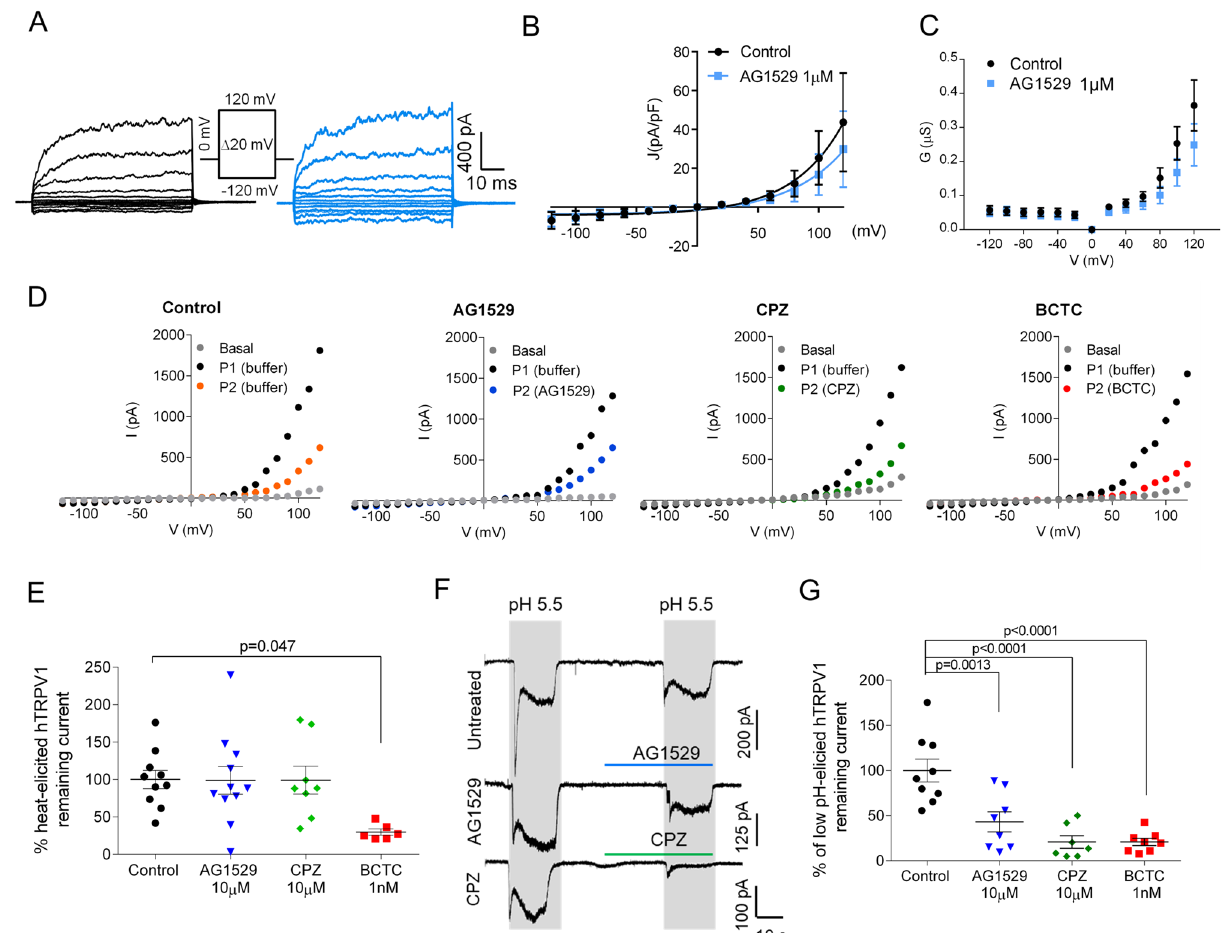
Figure 2. AG1529 modestly affects pH, voltage and heat activation. ( A ) Representative hTRPV1 current recordings elicited by voltage steps protocol from − 120 mV to 120 mV in 100 ms steps of 20 mV from a holding potential of 0 mV. Black traces represent currents evoked in the absence of AG1529, and blue traces in the presence of 1 µM AG1529. ( B ) Current density to voltage relationship for ionic currents in the absence (n = 8) and presence of the antagonist (n = 8). ( C ) Conductance to voltage relationship for the ionic currents in the absence and presence of the antagonist. Conductance values were estimated from the current density values, using as V r the x-intercept of the ionic current. ( D ) Representative I-V relationships of hTRPV1 ionic currents at 43 °C in the absence (control) and presence of 10 µM AG1529 (n = 11) or 10 µM capsazepine (CPZ, n = 7) or 1 nM BCTC (n = 6). Basal, denotes the ionic currents activated at 37 °C; P1 and P2, the ionic currents evoked at 43 °C in the absence and presence of the compounds, respectively. For control conditions, P2 was evoked in the absence of compounds (buffer) denoting the desensitization induced by heat and voltage. Ionic currents were recorded with a voltage ramp protocol from − 120 mV to 120 mV in 300 ms . Compounds were applied at 34 °C during 30 s before the second temperature increase to 43 °C. ( E ) Normalized voltage-evoked ionic current at 43 °C and + 120 mV, in the absence (control) and presence of the antagonists. Remaining TRPV1 current after P2 (desensitization) was used for normalization. Data are expressed as mean ± SEM, and were analysed using the One-Way Anova (F(3,31) = 3.5, p = 0.0269) followed by the Bonferroni´s post-hoc test, p-value for statistical difference is indicated. ( F ) Representative acid pH-elicited hTRPV1 ionic currents evoked by two pH 5.5 pulses in control cells (Untreated), and cells exposed to 10 µM AG1529 (AG1529) or 10 µM capsazepine (CPZ) for 30 s before the second pH pulse. Amiloride (50 µM) was used in all buffers to block endogenous ASIC channels expressed by cells. Currents were elicited at a holding V = -60 mV. ( G ) Normalized hTRPV1 pH-evoked inward currents elicited for control (n =9 ), 10 µM AG1529 (n = 8), 10 µM capsazepine (n = 7) and 1 nM BCTC (n =8 ). Normalized responses were estimated as (I pH2 /I pH1 ) × 100. Grey rectangles denote the duration of the pH pulses and horizontal lines the duration of the antagonists pulses. All data is expressed as mean ± SEM. Data were analysed using the One-Way Anova (F(3,28) = 15.5, p < 0.0001) followed by the Bonferroni´s post-hoc test, p-values for statistical difference are